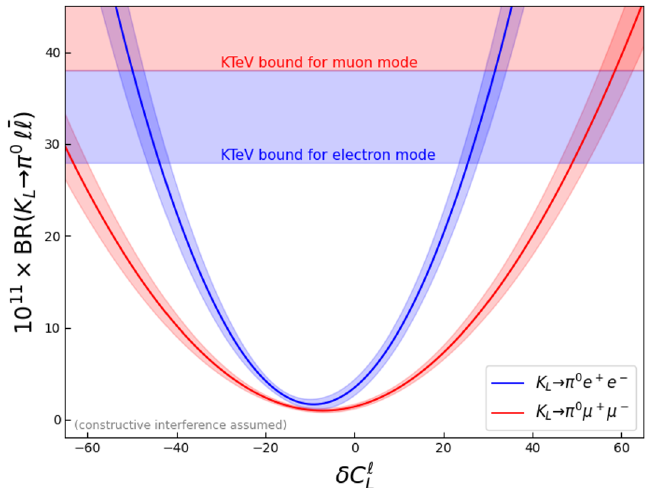
( ≡ C ‘ = − C ‘ ) assuming constructive interference 9 10 L